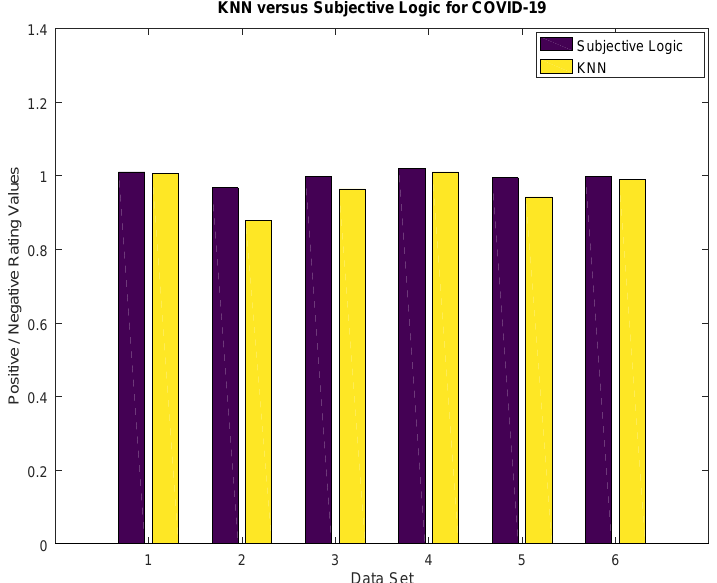
Figure 13. KNN vs. subjective logic for COVID-19